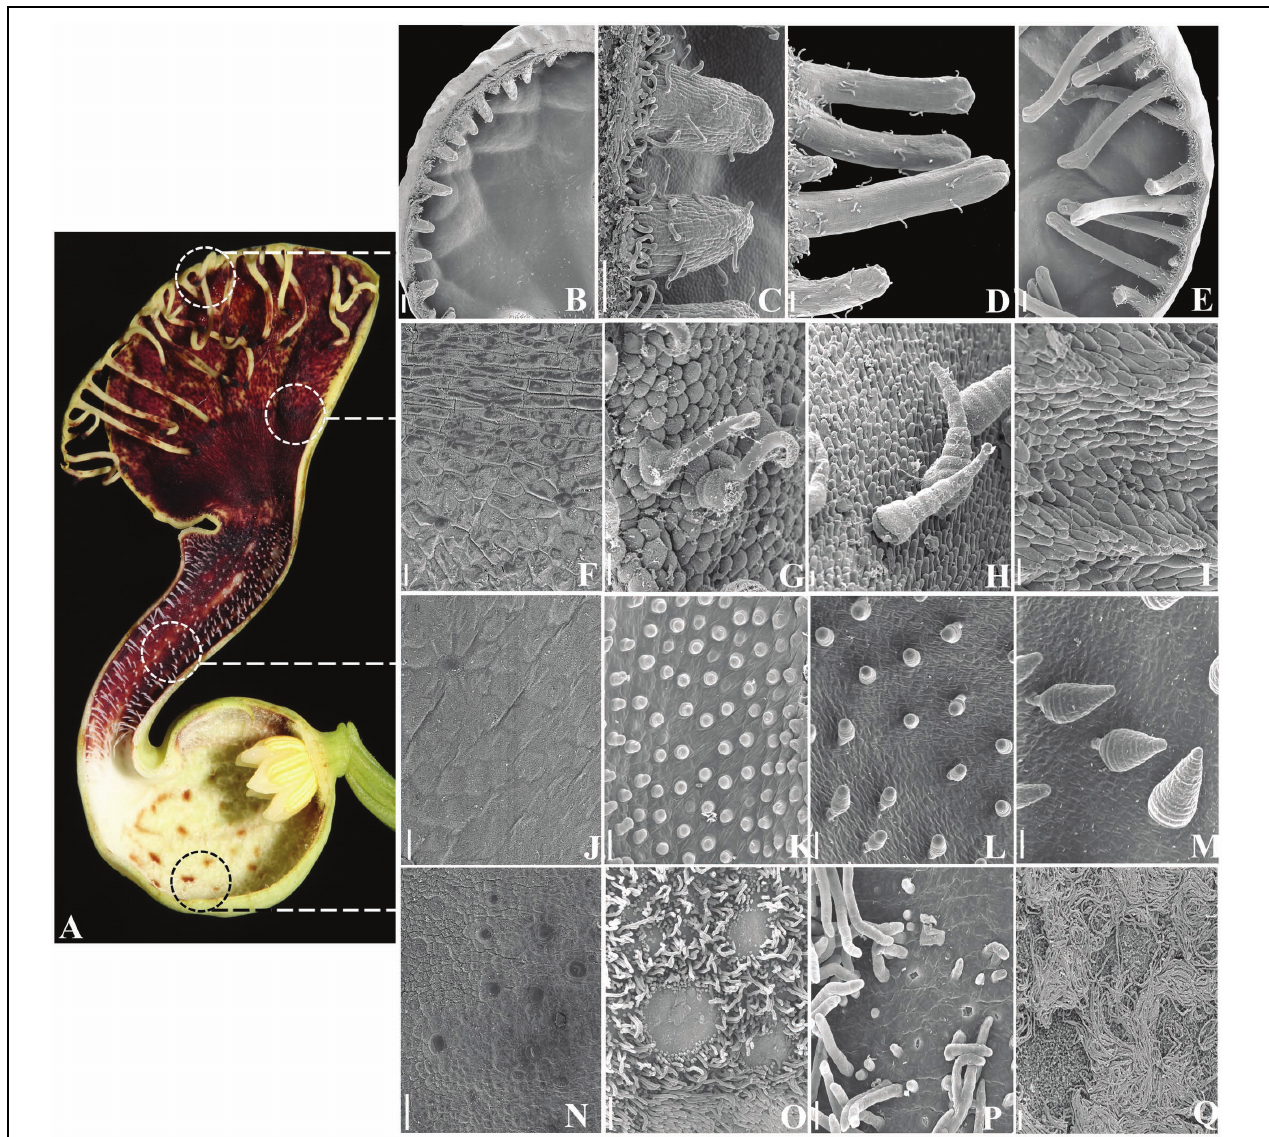
FIGURE 4 | Aristolochia fimbriata , epidermal differentiation of the perianth. (A) Preanthethic flower, longitudinal section. (B–E) Fimbriae development and ornamentation. (F–I) Ornamentation of the abaxial (F) and adaxial (G–I) epidermis of the limb. (J–M) Ornamentation of the abaxial (J) and adaxial (K–M) epidermis of the tube. (N–Q) Ornamentation of the abaxial (N) and adaxial (O–Q) epidermis of the utricle. Scale bars: (B,E) : 200 μ m; (C,D,O) : 100 μ m; (F–N,P) : 20 μ m; (P) : 50 μ